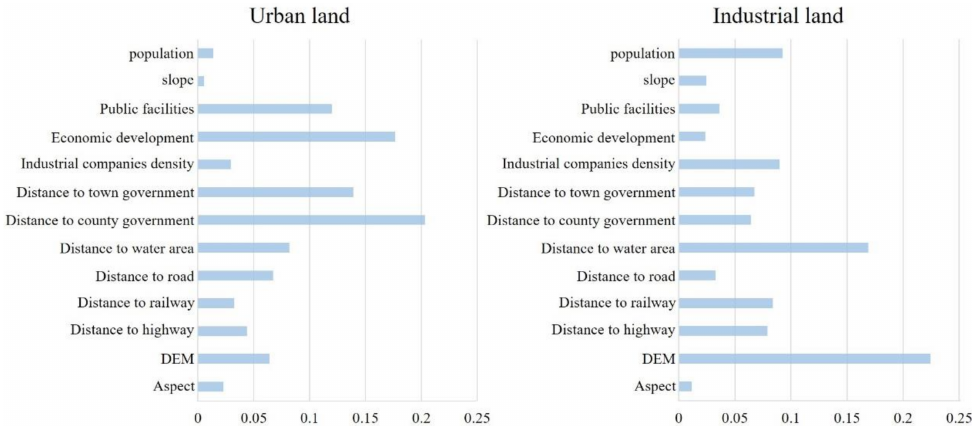
Figure 6. The contribution of each driving factor to the growth of urban land and industrial land.